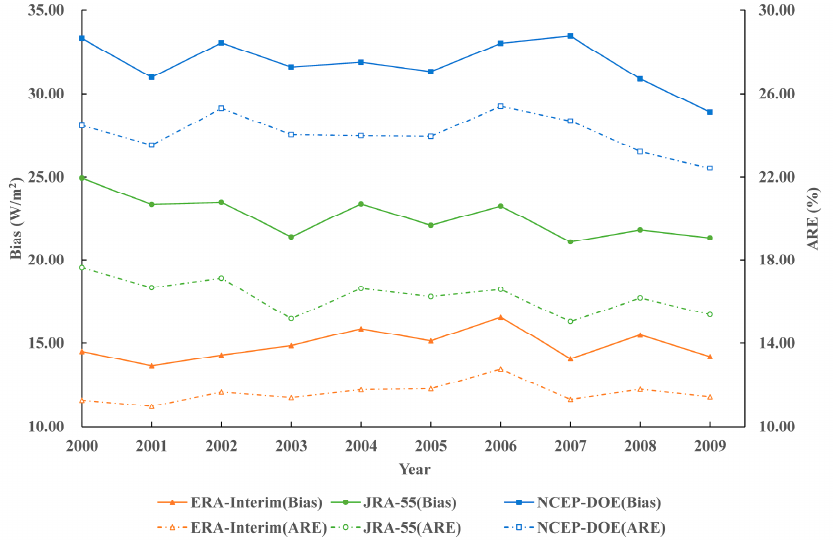
Figure 2. Annual series of bias and ARE of the three solar radiation reanalysis products from 2000 to 2009.